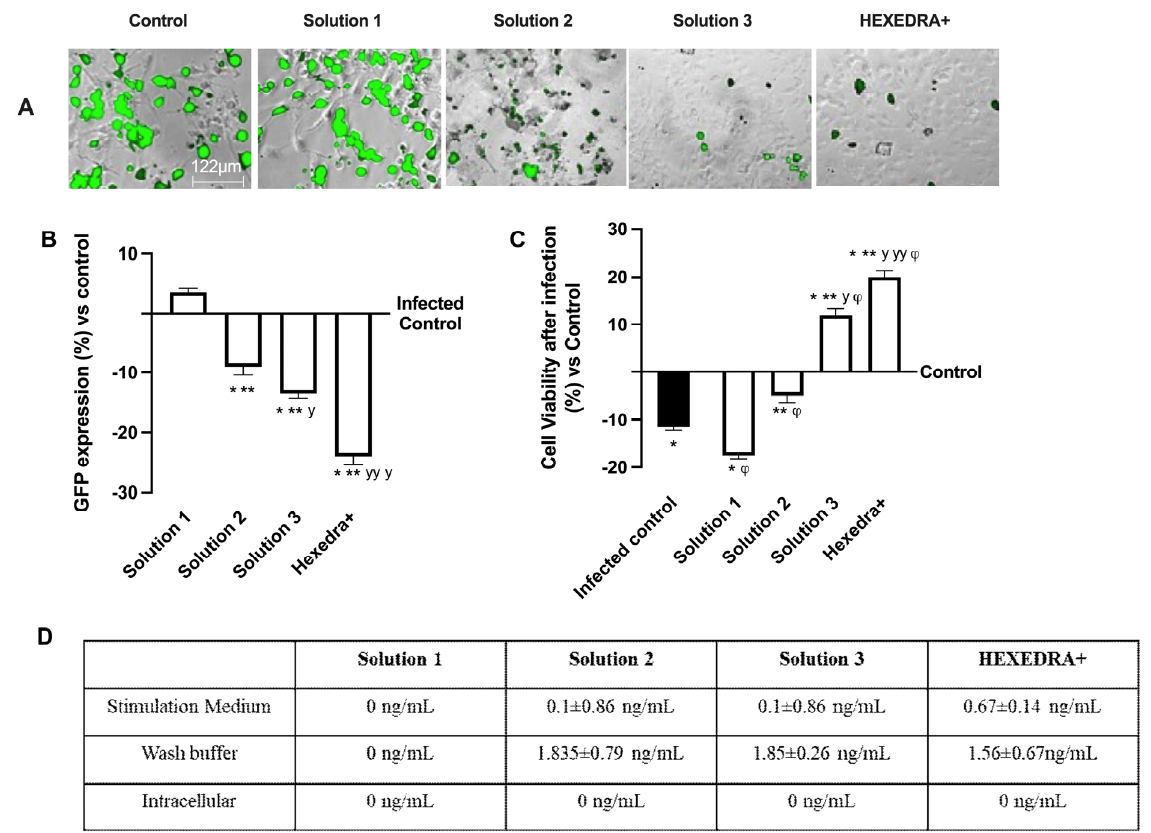
Figure 2. Analysis of infection of Vero E6 cells with VSV-based pseudovirus SARS-CoV-2 (MOI 0.1) pre-treated with the different UA-based formulations. In ( A ), the images reported were an example of each stimulation for GFP fluorescence expression obtained at 40× magnification by Paula (Leica DM1000); in ( B ) the analysis of GFP expression in cells obtained by the image analysis using Image J Software and the results were expressed as mean ± SD (%) compared to infected control cells (0 line) of four independent experiments. In ( C ), cell viability measured by MTT test after infection and expressed as mean ± SD (%) compared to uninfected control cells (0 line) obtained from four independent experiments. In ( D ) UA spectrophotometry quantification at 281 nm by Tecan (Infinite 200 Pro Mplex, Tecan, Milan, Italy) and data are expressed as ng/mL ± SD of four independent experiments. Solution 1 = 150 mcg/mL 𝛽 -CD +HPMC; Solution 2 = 150 mcg/mL UA+ 150 mcg/mL 𝛽 -CD + 1% HPMC; Solution 3 = 75 mcg/mL UA+ 150 mcg/mL 𝛽 -CD + 1% HPMC; HEXEDRA+ = 75 mcg/mL UA+ 150 mcg/mL 𝛽 -CD + 0.1% Tpmix + 1% HPMC. * p < 0.05 vs. Control; ** p < 0.05 vs. Solution 1; y p < 0.05 vs. Solution 2; yy p < 0.05 vs. Solution 3; φ p < 0.05 vs. Infected control.